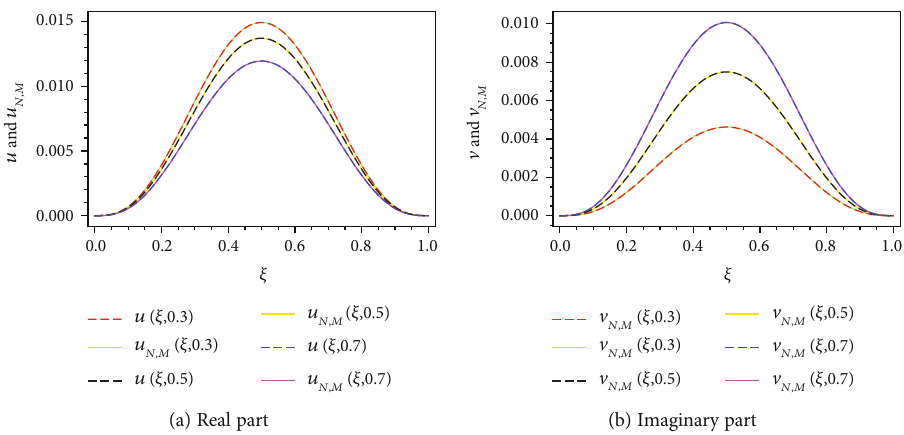
Figure 2: ξ -direction curves for the approximate and exact solutions of real and imaginary parts of Equation